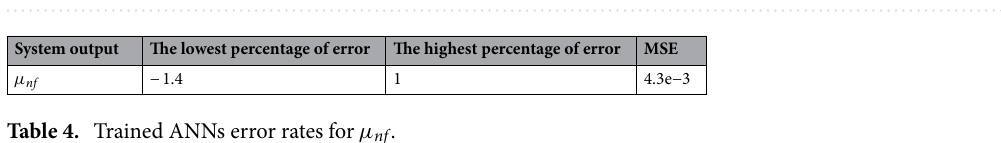
Table 4. Trained ANNs error rates for µ nf